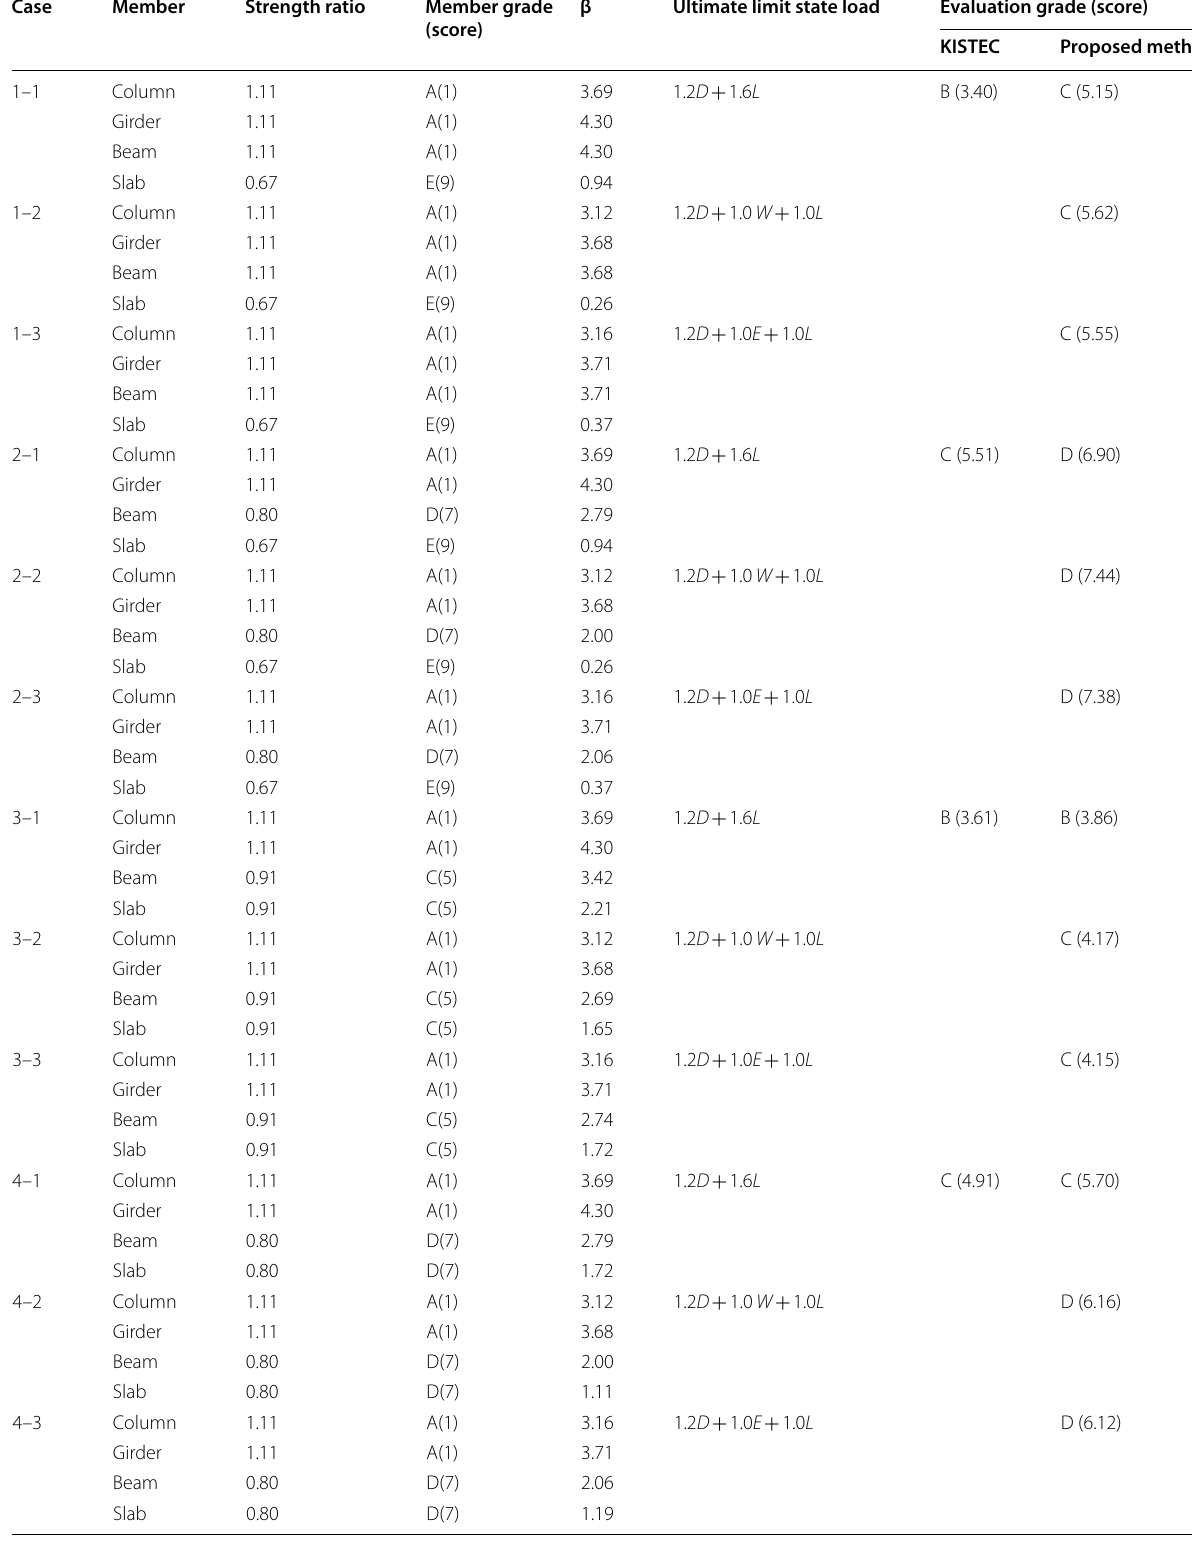
Table 7 Comparison of results between KISTEC method and proposed